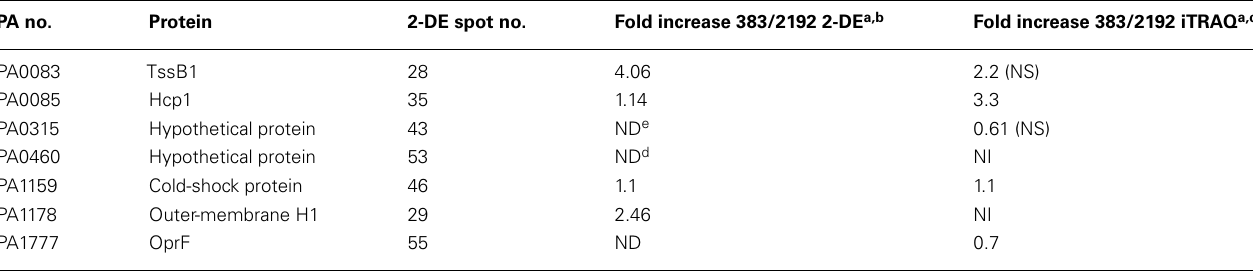
Table 3 | Selected proteins quantified from cored protein spots of 2-DE. PA